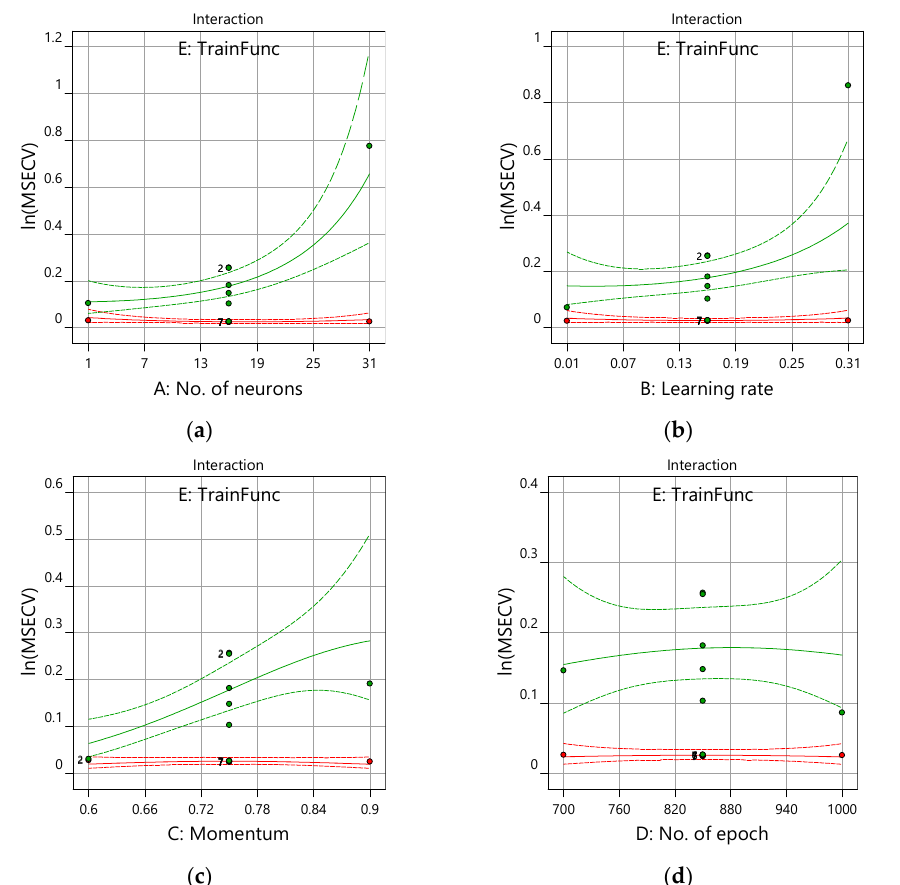
Figure 9. Interaction plot for the ANN training parameters of ln(MSECV) versus the ( a ) number of neurons, ( b ) learning rate, ( c ) momentum, and ( d ) number of epochs. trainlm —red ; traingdm —green.